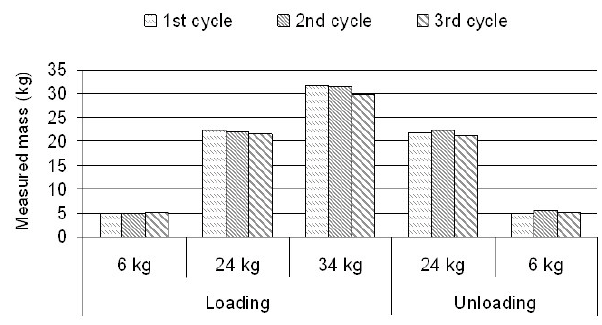
Fig. 5. Measured mass given by the slipper when loading and unloading at 6 kg, 24 kg, 34 kg, 24 kg and 6 kg, in three consecutive cycles, separated by total unloading and offset